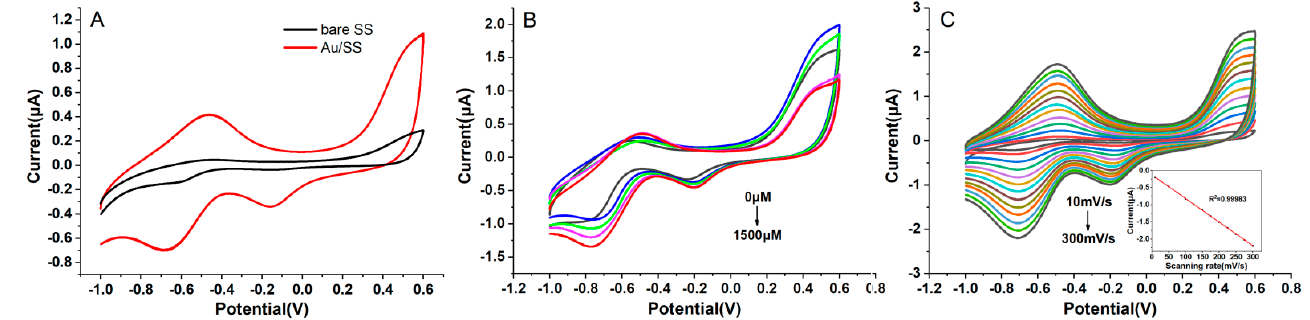
Figure 2. ( A ) CV curves of bare SS, and Au/SS wire-based electrochemical microsensor in the presence of 100 µ M H 2 O 2 in 0.2M PBS with pH 7 solution at the scanning rate of 100 mV · s − 1 . ( B ) CV curves of Au/SS wire-based electrochemical microsensor in the absence of H 2 O 2 and the presence of different concentrations of H 2 O 2 in 0.2M PBS with pH 7 solution at the scanning rate of 100 mV·s − 1 . The concentrations of H 2 O 2 were 0 µM (control, black line), 100µM (blue line), 500µM (green line), 1000µM (pink line), and 1500 µM (red line), respectively. ( C ) CV curves of SS wire-based electrochemical microsensor at different scanning rates in 100 µ M H 2 O 2 solution. The scanning rate ranges from 10 to 300 mV · s − 1